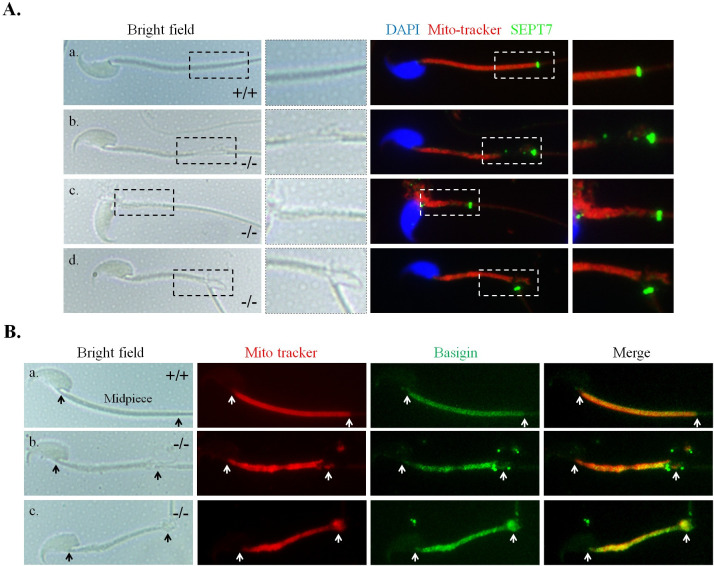
The annulus structure and function of sperm tail is intact in Tbc1d21-/- mice.(A) Sperm from wild-type and Tbc1d21-/- mice stained with SEPT7 antibody (green), Mito-tracker (red), and DAPI (blue). Figures from left to right indicate the bright field (Bright field), enlarged square from bright field, immune-staining figure (DAPI, Mito-tracker, and SEPT7), and enlarged square from immune-staining figure. Arrows point out the where annulus sits (SEPT7 signals, green). Figure a. for wild-type mice, and Figures b.-d. from Tbc1d21-/- mice. (B) Sperm from wild-type (a.) and Tbc1d21-/- (b. and c.) mice stained with Mito-tracker (red), and Basigin antibody (green). Figures from left to right indicate bright field, staining with the Mito-tracker (red), immune-staining with Basigin antibody (green) and merged figures. The length of the midpiece is indicated between the white arrows.